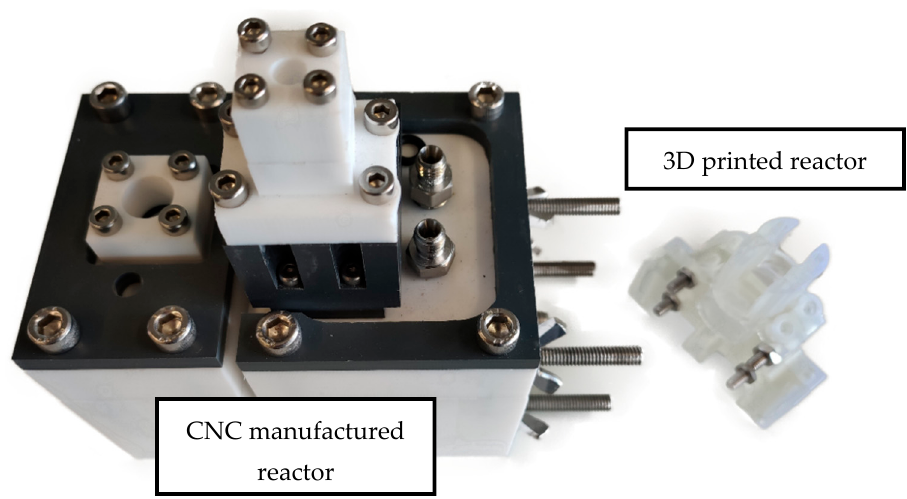
Figure 5. The old CNC manufactured reactor on the left compared with the novel 3D printed reactor